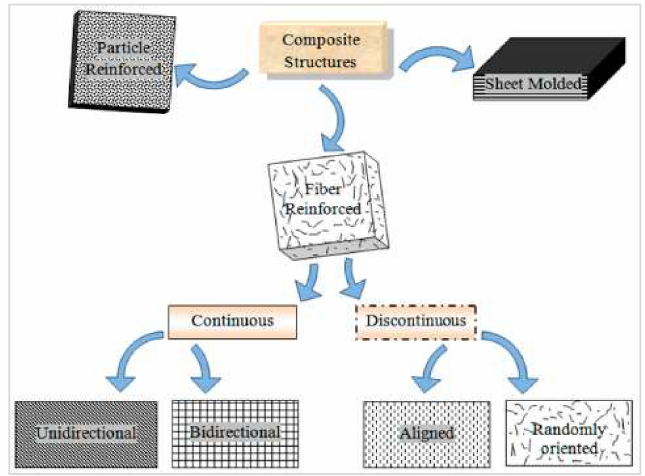
Figure 17. Classification of plant-fiber-reinforced composites